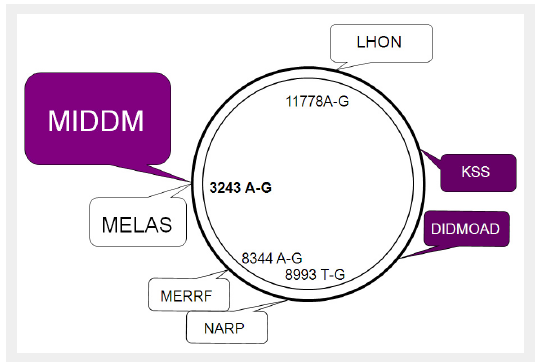
Mitochondrial DNA schematically depicted as circular double-strand DNA with some mutation syndromes. MIDDM = maternally inherited deafness and diabetes mellitus; MELAS = mitochondrial encephalomyopathy, lactic azidosis and stroke-like episodes; DIDMOAD = diabetes insipidus, diabetes mellitus, optic atrophy, and deafness; KSS = Kearns-Sayre syndrome; LHON = Leber‘s hereditary optic neuropathy; MERRF = myoclonic epilepsy, ragged-red fibers; NARP = neuropathy, ataxia, and retinitis pigmentosa.